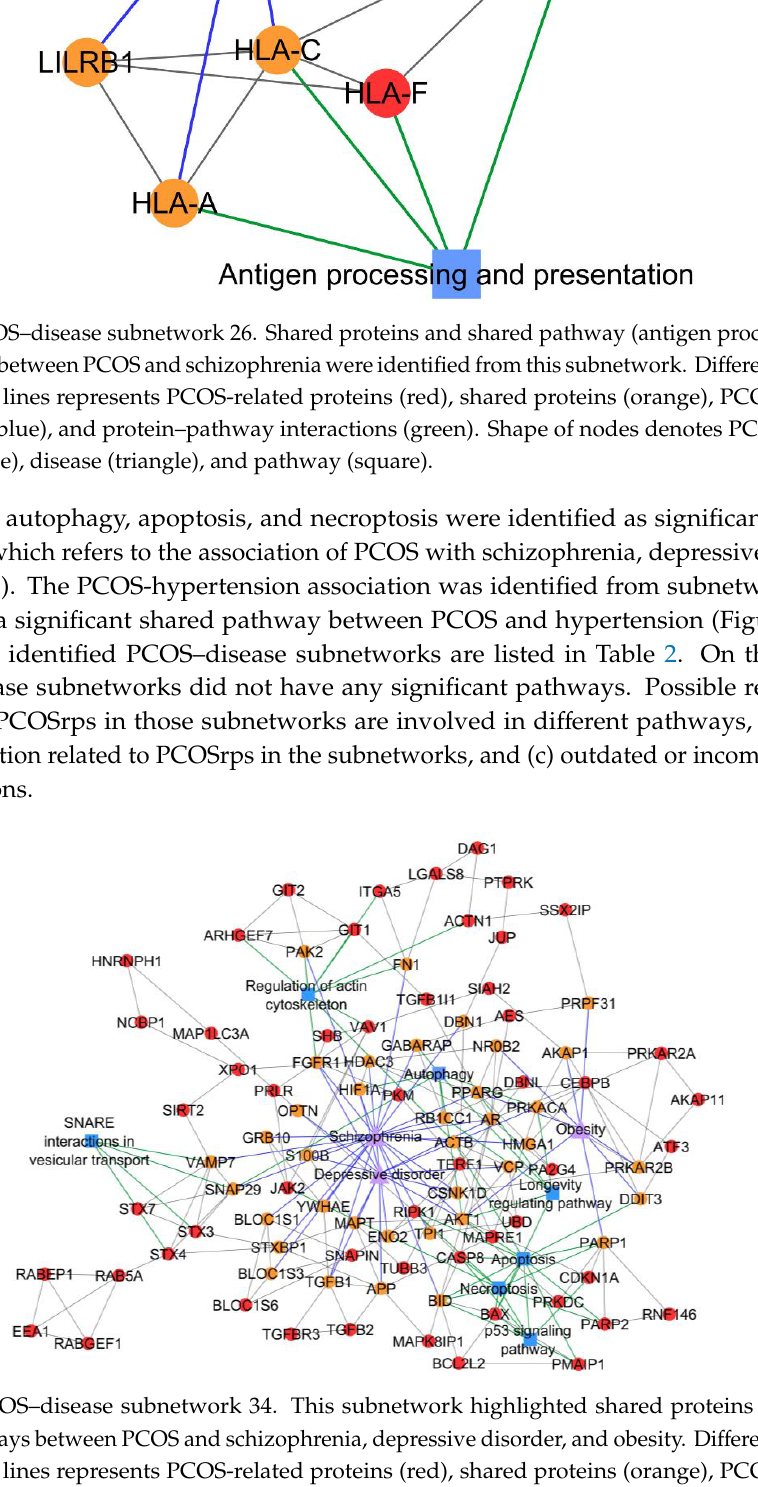
Figure 5. PCOS–disease subnetwork 34. This subnetwork highlighted shared proteins and seven shared pathways between PCOS and schizophrenia, depressive disorder, and obesity. Different coloring of nodes and lines represents PCOS-related proteins (red), shared proteins (orange), PCOS–disease interactions (blue), and protein–pathway interactions (green). Shape of nodes denotes PCOS-related proteins (circle), diseases (triangle), and pathways (square).